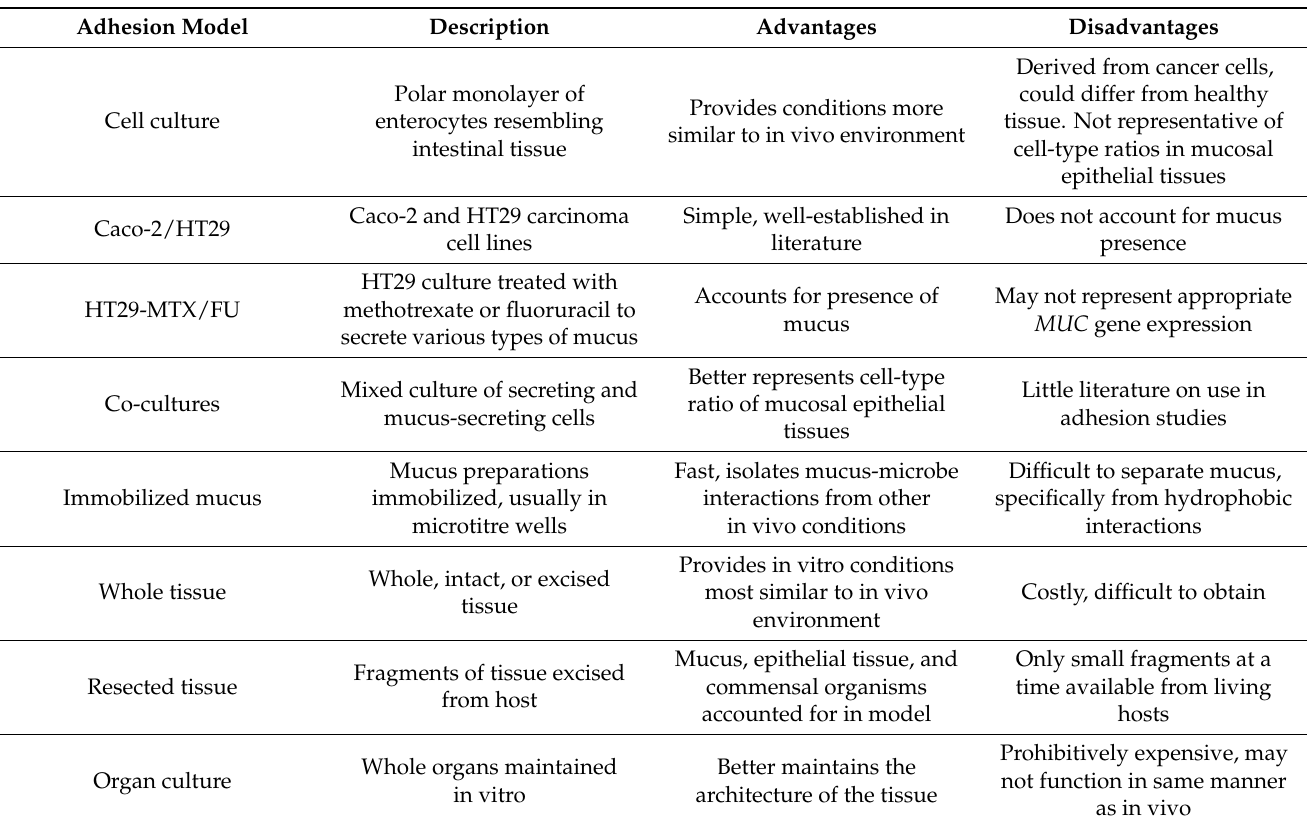
Table 2. Advantages and disadvantages of various types of in vitro bacterial adhesion models (Modified from Van Tassell and Miller, 2011)